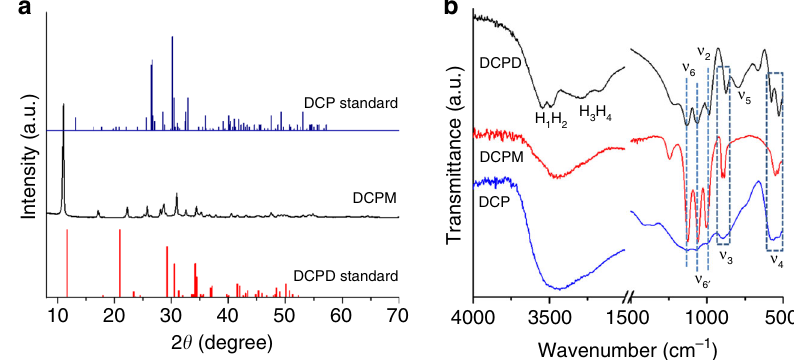
Fig. 3 Characterization of DCPD, DCPM, and DCP with XRPD and IR spectroscopy. a Comparison of the XRPD pattern of DCPM with the standard diffractograms of DCPD (JCPDS 09-0077) and DCP (JCPDS 09-0080). b The IR spectra of DCPD, DCPM, and DCP. The assignment of vibration modes follows Bailey and Holt 48 . Source data are provided as a Source Data fi